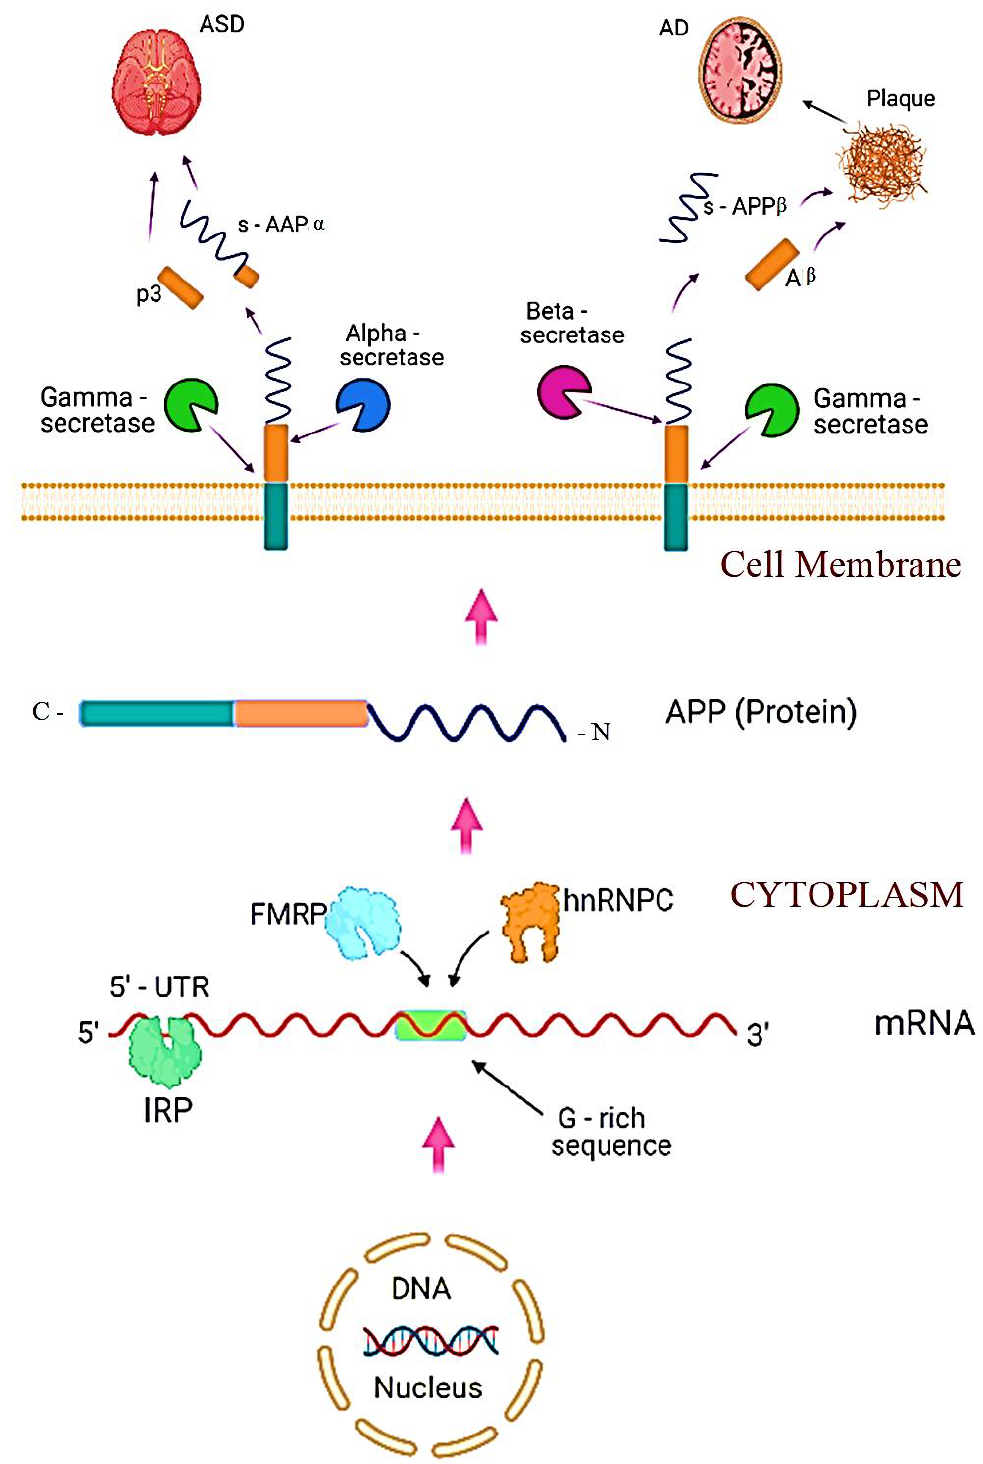
Figure 3. Parallel yet divergent proposed mechanism of ASD and AD pathogenesis. Transport and translation of APP mRNA are well regulated by mRNA transport proteins and RNA binding proteins, such as IRPs and FMRP and miRNAs. There is a G-rich domain in the coding region of mRNA. FMRP and hnRNPC compete to bind this domain to suppress or enhance translation, respectively. APP is a transmembrane protein that is processed by combinations of α -, β -, and γ -secretases, resulting in different product combinations. p3 and s-AAP α promote ASD downstream, while s-APP β and Aβ , in combination with other molecules, result in the formation of senile plaques and cause AD.